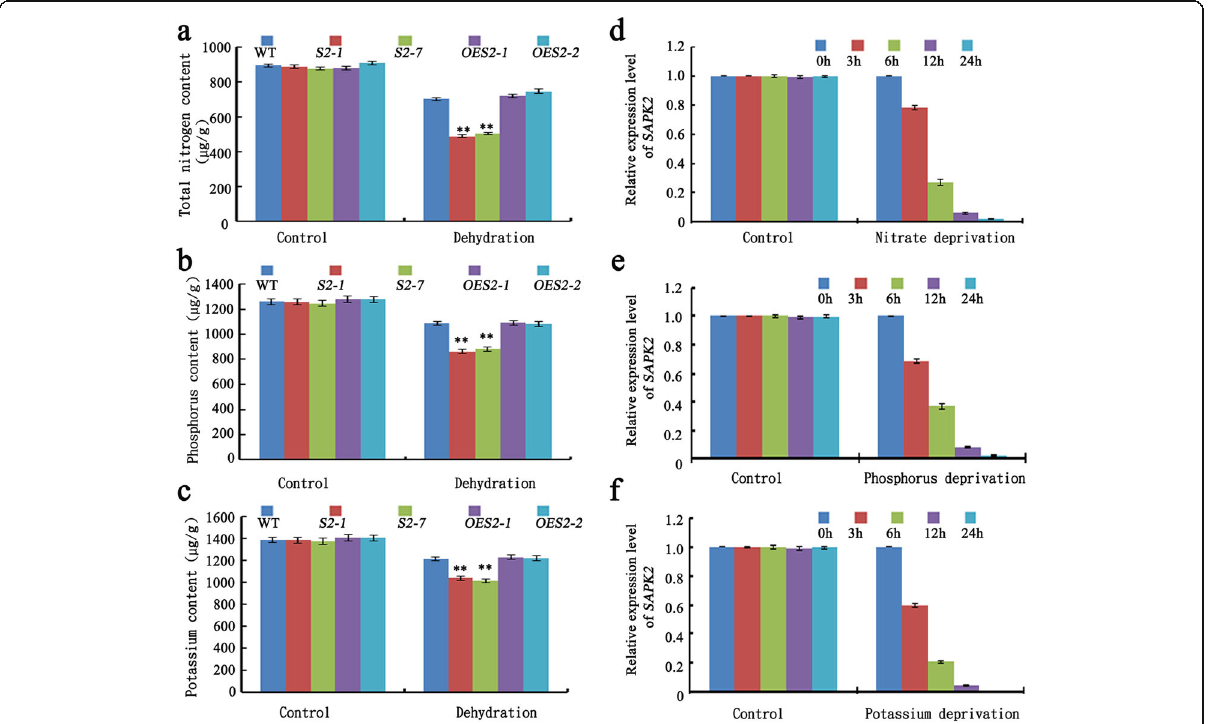
Fig. 3 SAPK2 influenced Nitrate, phosphorus, potassium content in rice grains under reproductive-stage drought. a-c Comparison of nutrient content including total nitrogen ( a ), phosphorus ( b ), potassium ( c ) among WT, sapk2 mutant lines and OE lines in rice seeds under reproductive- stage drought. d-f The expression analysis of SAPK2 under N ( d ), P ( e ), and K ( f ) deprivation. Transcript accumulation was assessed by qRT-PCR. Data are shown as means ± SD ( n = 20) from three replicates. A student ’ s t -test was used to generate P values; “ ** ” indicate significance at P <